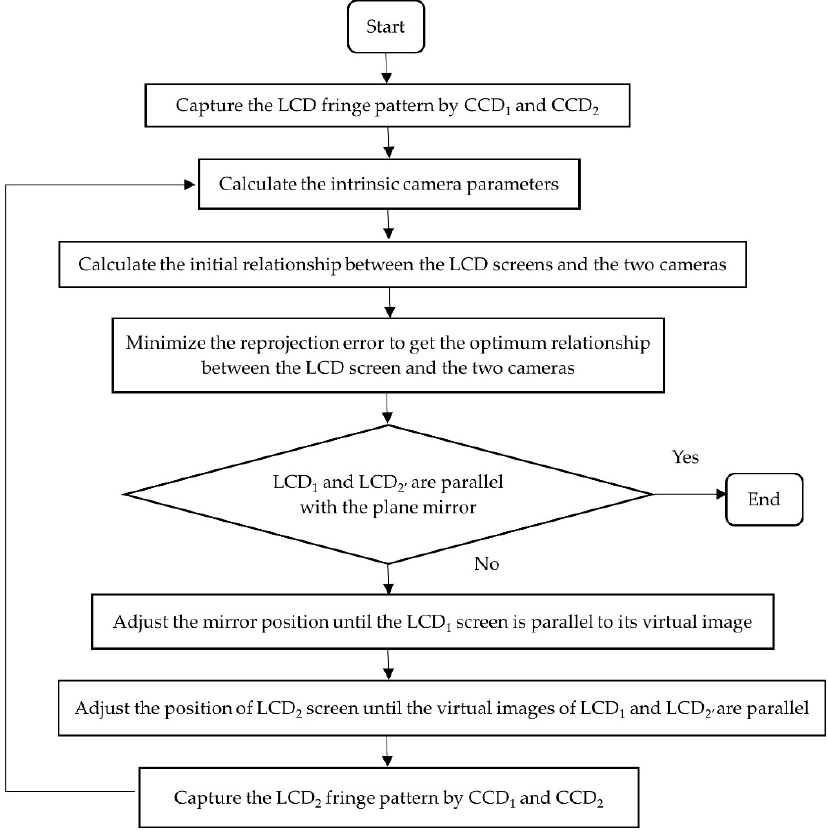
Figure 5. The workflow of the calibration process.